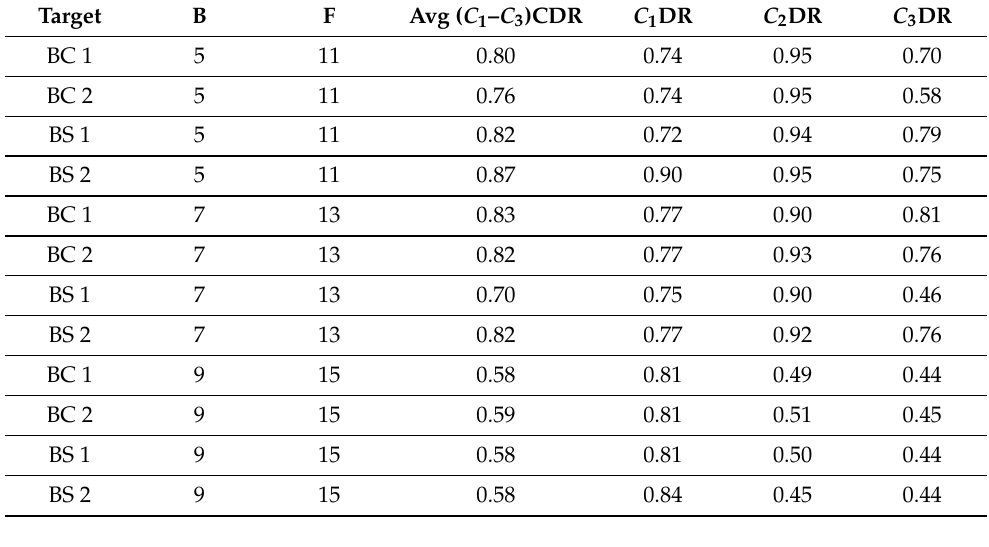
Table 18. The crack detection ratio (CDR) of sharpened images by convoluted PSF.